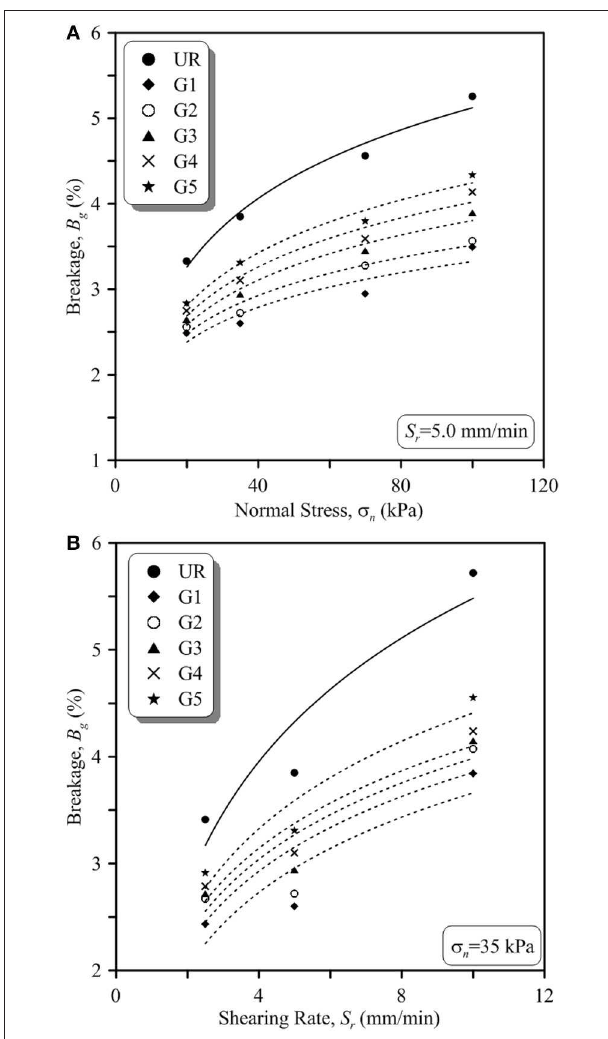
FIGURE 5 | Variation of breakage of unreinforced and geogrid-reinforced ballast with (A) applied normal stress at S r = 5.0 mm/min and (B) shearing rates at σ n = 35 kPa.